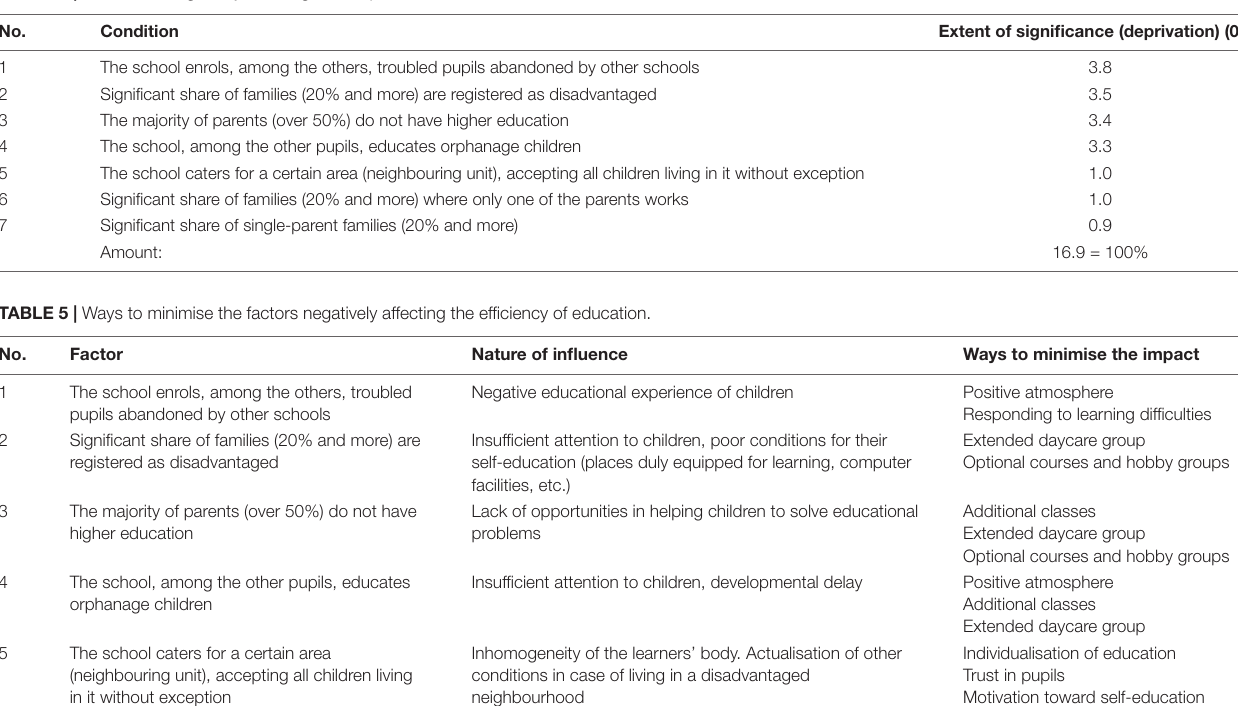
TABLE 4 | Conditions negatively affecting school performance.